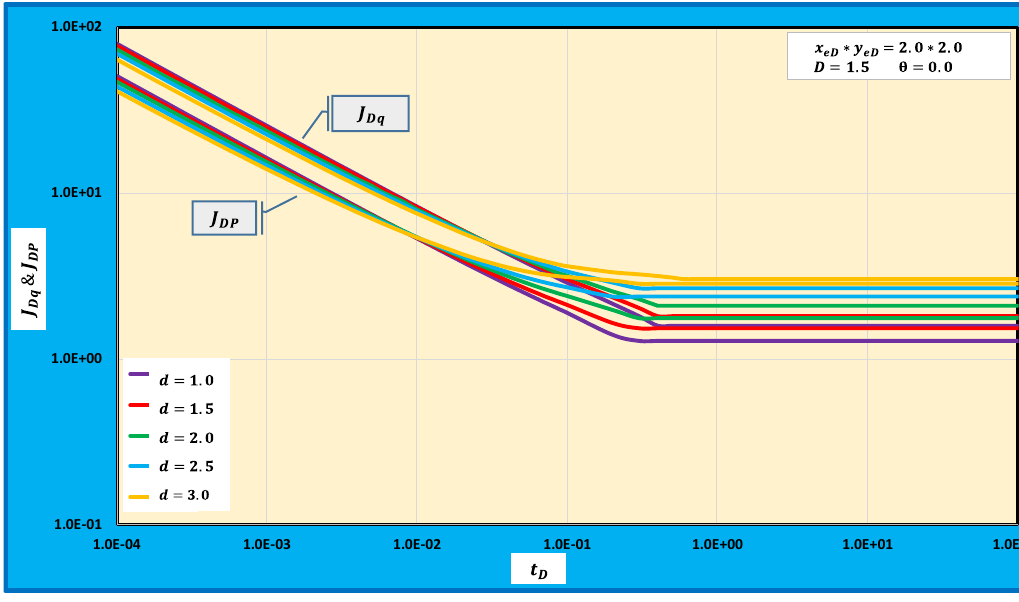
Fig. 16 Productivity index behaviors for different mass fractal